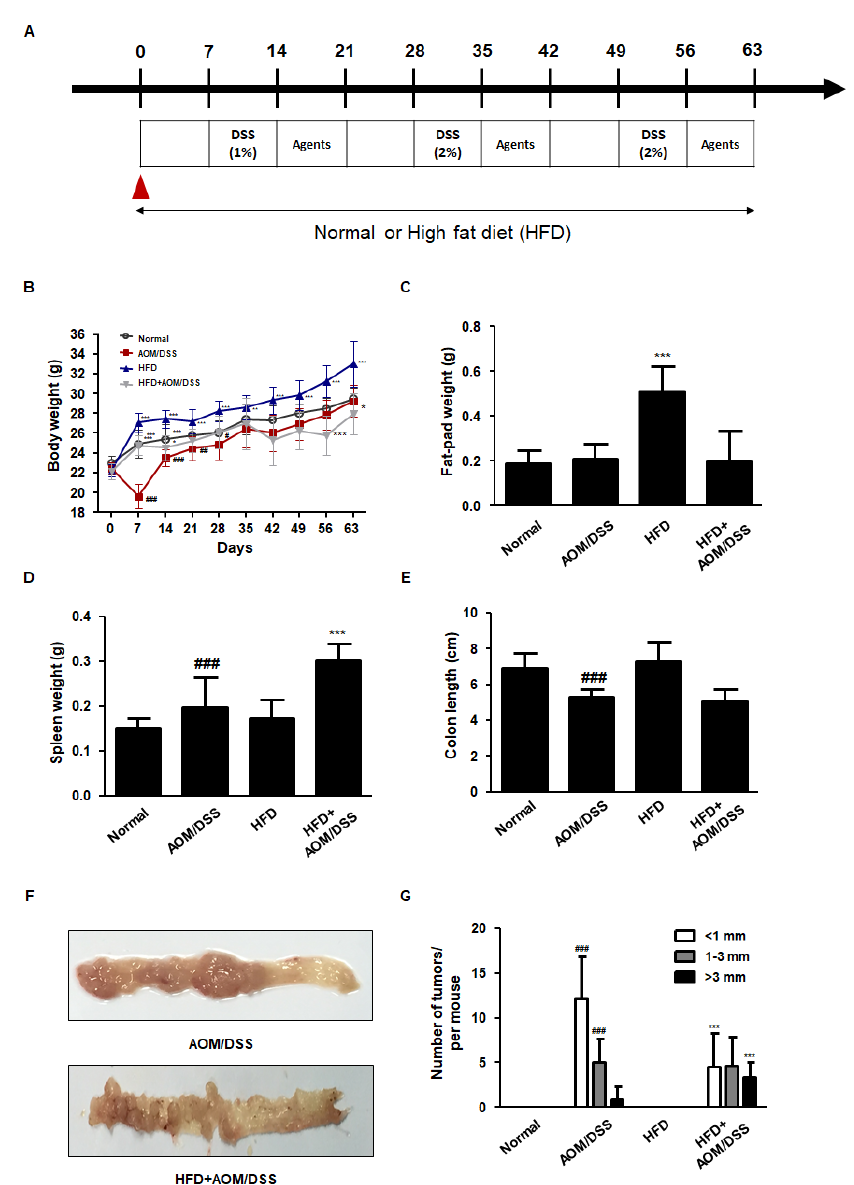
Figure 1. E ff ects of HFD on the pathological symptoms in the AOM / DSS-induced CAC mice model. ( A ) Scheme of the AOM / DSS-induced CAC mice fed on normal diet or HFD. ( B – G ) The animals were randomly divided into four groups: normal group, AOM / DSS group (AOM / DSS-induced CAC mice), HFD group (mice fed HFD), and HFD + AOM / DSS group (AOM / DSS-induced CAC mice fed HFD). ( B ) Body weight, ( C ) fat-pad weight, ( D ) splenic weight, and ( E ) colon length were evaluated in each mouse. ( F ) Representative photograph of the colon tissues from the AOM / DSS and HFD + AOM / DSS groups is shown. ( G ) The number of tumors in each group was measured. The values are the mean ± SD ( n = 10); ### p < 0.001 vs. normal group; * p < 0.05, *** p < 0.001 vs. AOM / DSS group; significant di ff erences between the treated groups were determined by ANOVA and Dunnett’s post-hoc test.